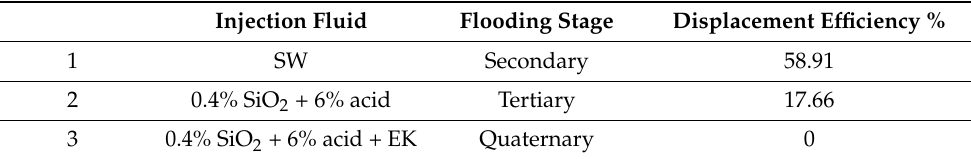
2 to prevent precipitation observed in previous studies. However, there was no oil produc- A/m